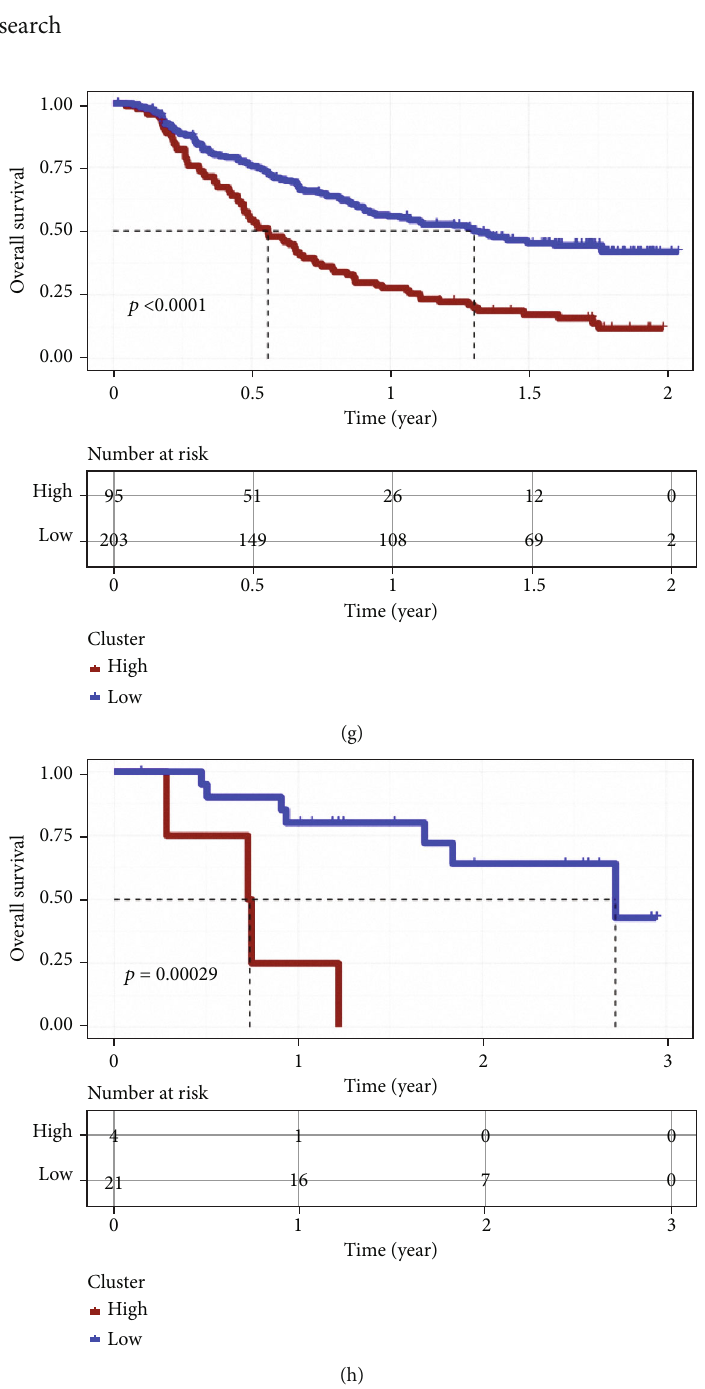
Figure 6: Construction and validation of the prediction model. (a, b) Correlation of the risk value and survival time in training and testing cohort. (c, d) OS analysis of high- and low-risk groups in the training and testing cohorts. (e, f) ROC curve for predicting model in the training and testing cohorts. (g, h) OS analysis of the high- and low-risk groups in the validation cohort (g: metastatic urothelial cancer patients, h: melanoma